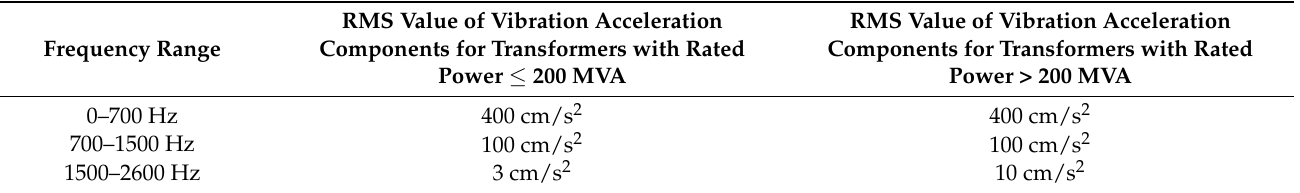
Table 2. Limit values of the components of the vibration spectrum for different frequency